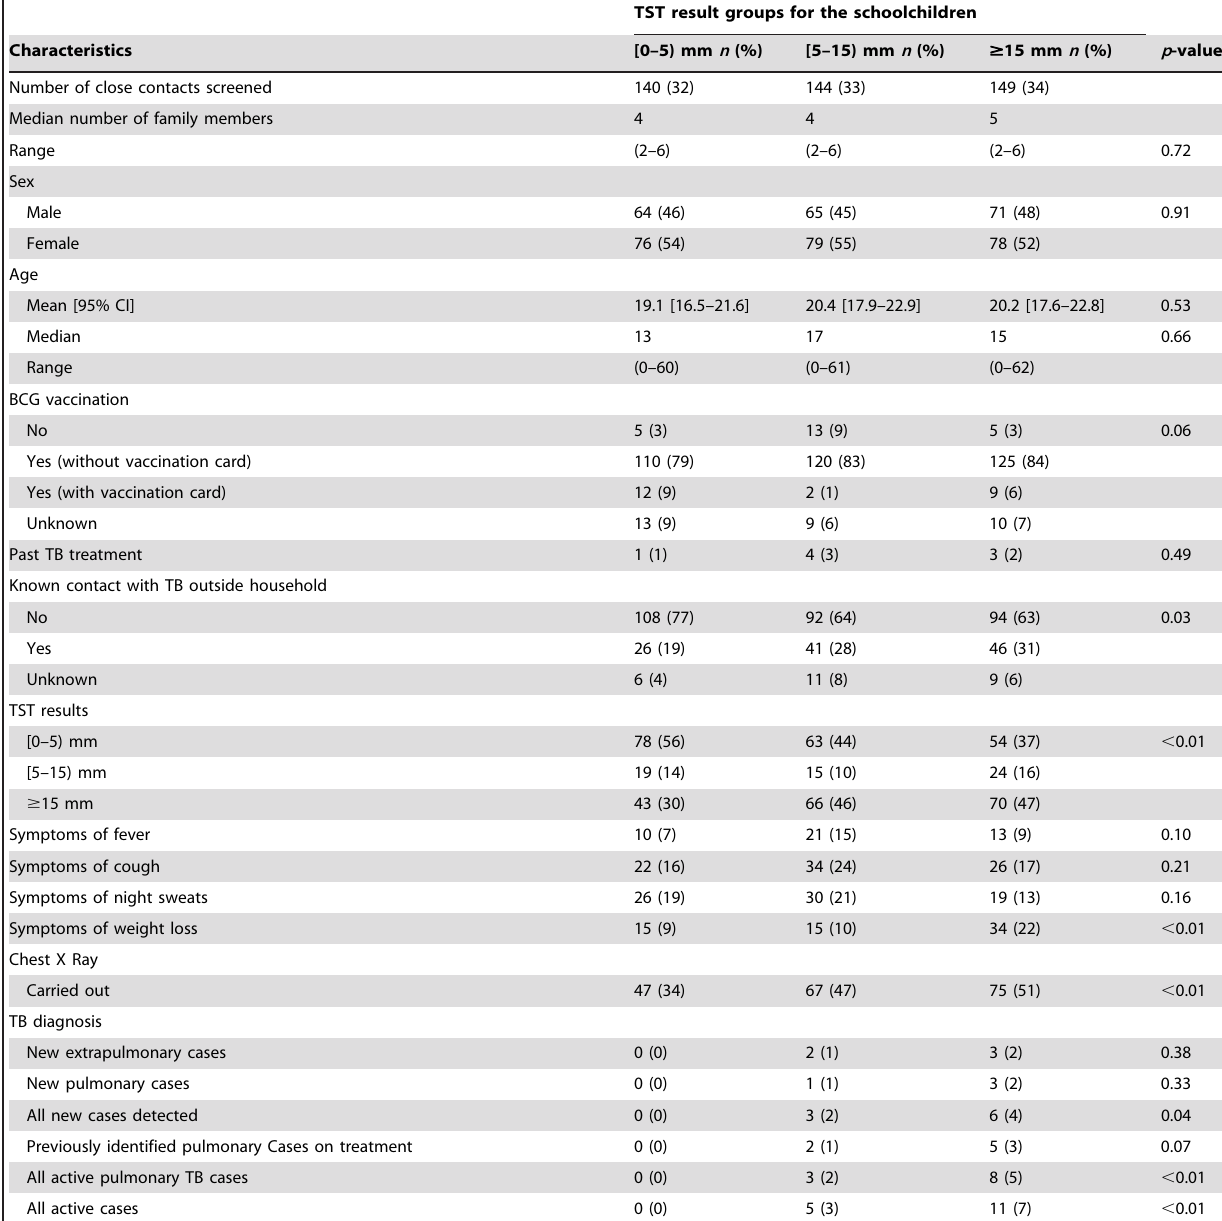
Table 2. Characteristics of close contacts according to the TST status of the schoolchildren.